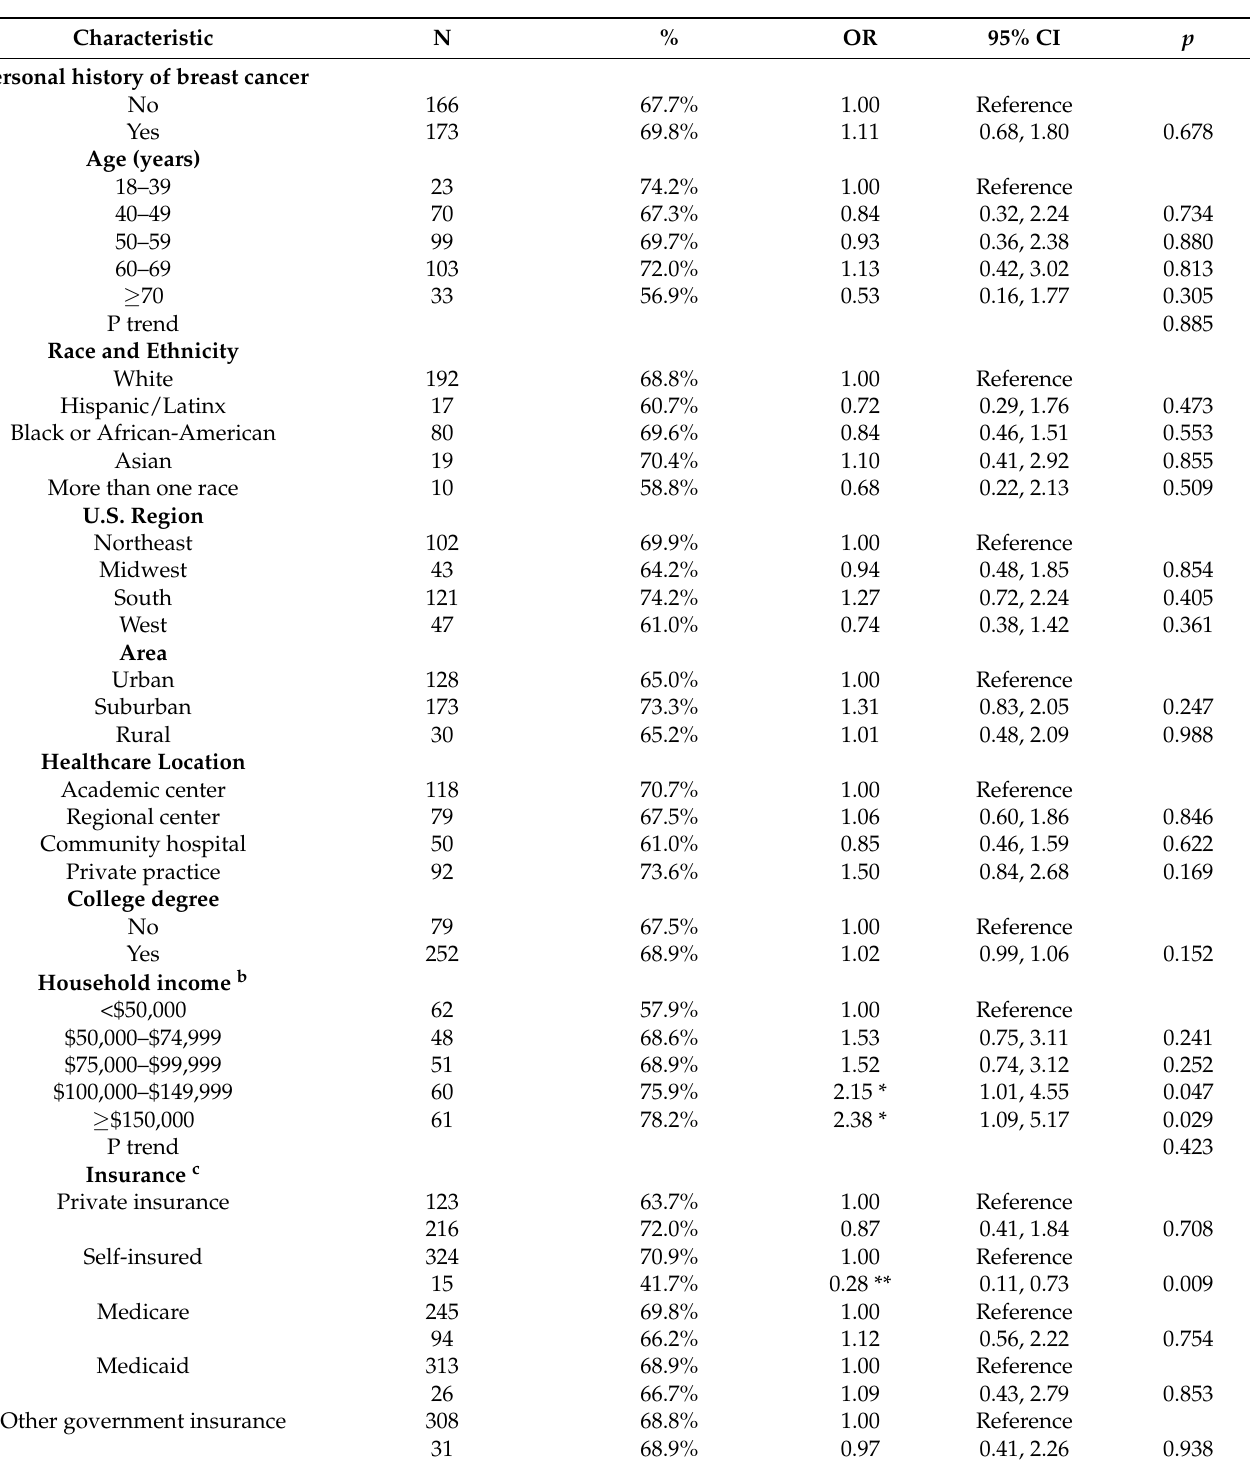
Table 3. Number, percent and adjusted odds ratio of telemedicine use by sociodemographic factors (n = 491) a